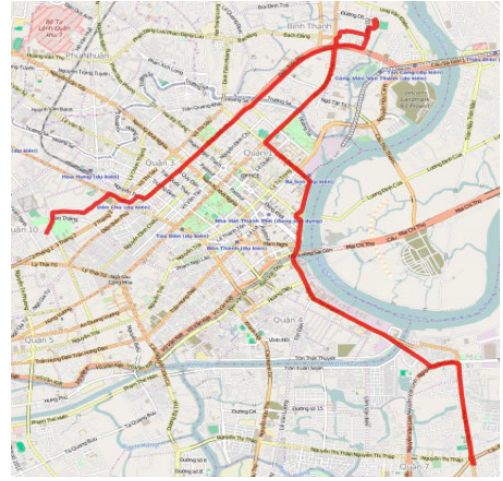
Fig.2. An example of a GPS